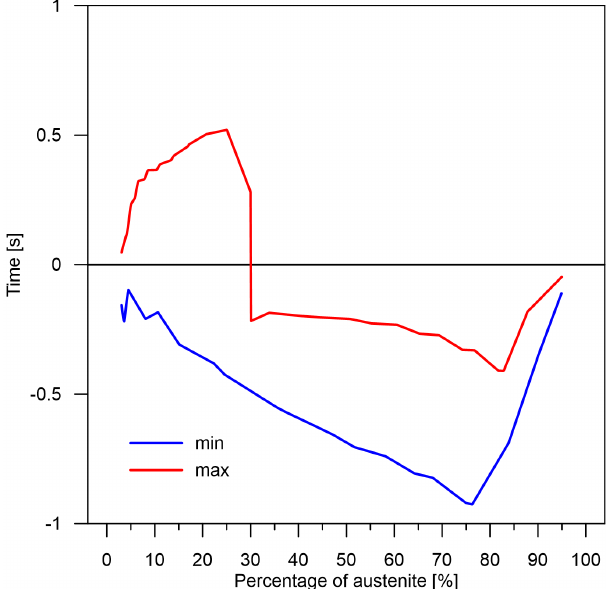
Figure 15. Time to achieve the required level of transformation for case No. 3 (difference between analytical and RNN model—rates with largest